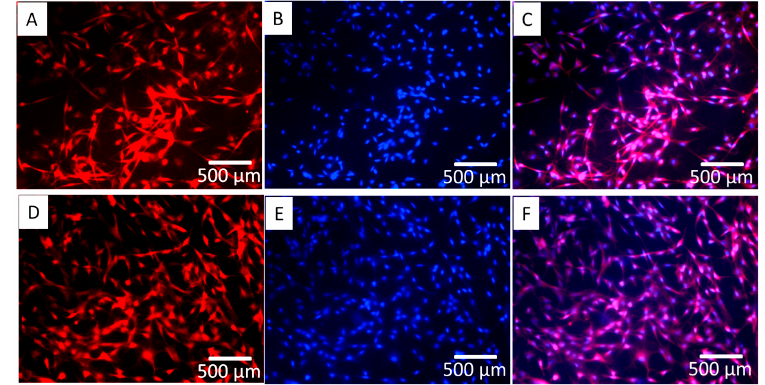
Figure 4. Immunostaining of actin, and nuclei showing mBMSC cells cultured on PLLA NF and ECM/PLLA NF, respectively: ( A – C ) actin staining, DAPI staining, and merged image of mBMSCs on PLLA NF at day 7; ( D – F ) actin staining, DAPI staining, and merged image of mBMSCs on ECM/PLLA NF at day 7; Red: actin; Blue: nuclei.